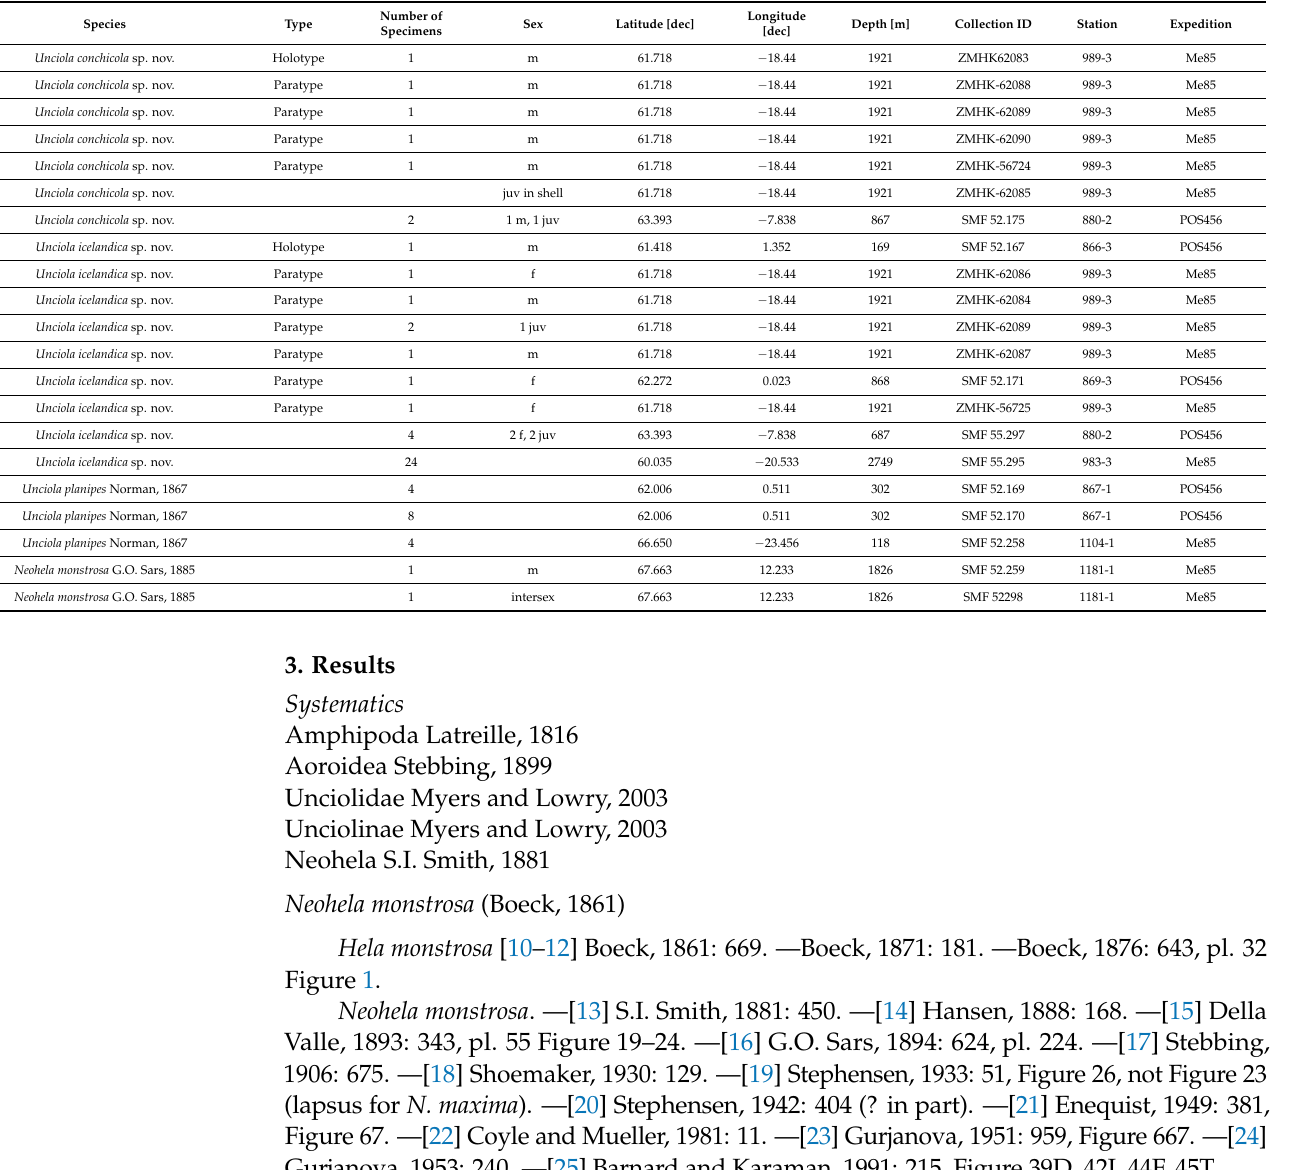
Table 1. Examined material of unciolid genera Unciola and Neohela collected during IceAGE